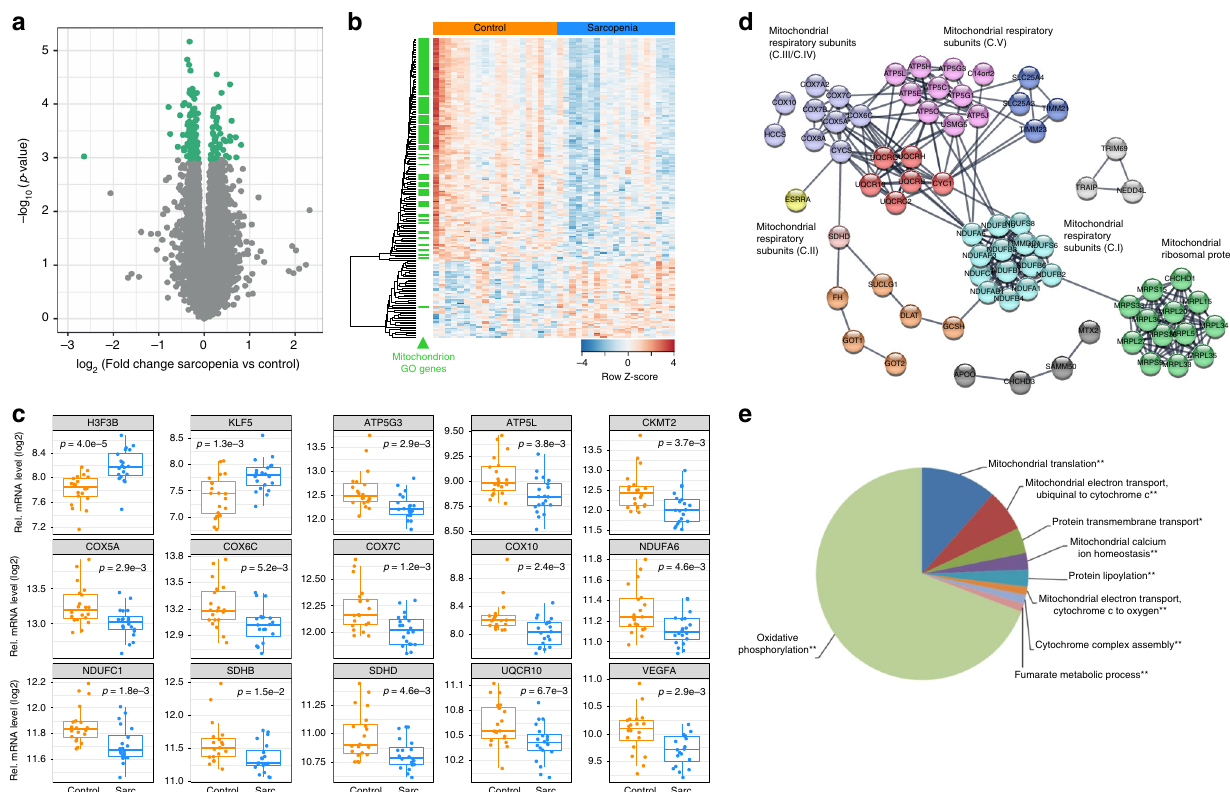
Fig. 1 RNA sequencing of human skeletal muscle in SSS. a Volcano plot of differentially expressed genes in skeletal muscle of sarcopenic vs. age-matched healthy older people. p -values were calculated using moderated t-statistic. The 133 genes downregulated and 46 genes upregulated in sarcopenic muscle using a false-discovery rate (FDR) < 10% are represented in green. b Heatmap showing the 179 genes differentially expressed from ( a ) with FDR < 10%. Genes belonging to the cellular component GO term “ mitochondrion ” (GO:0005739) are labeled with a green tick. c Validation of gene expression changes in sarcopenic muscle of SSS for selected genes using quantitative mRNA pro fi ling by nanoString nCounter; mRNA expression values are normalized to ten stable housekeeping genes. n = 40 muscle samples analyzed with a two sided t test. d Network representation of the protein-protein interactions of genes differentially regulated in sarcopenic muscle at FDR < 10% using STRING. Nodes with an interaction score > 0.9 are represented and colored by biological function. e Gene ontology enrichment of the genes regulated in sarcopenic muscle. Pie-chart represents the % of differentially expressed genes, * p < 0.05 and ** p < 0.01 based on hypergeometric distribution tests. In a , b , d , e , n = 19 – 20 muscle samples per group from SSS